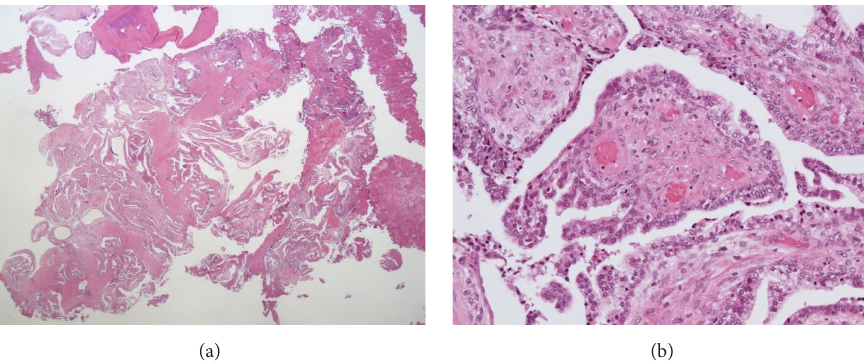
Figure 3: Pathological findings of TUR ((a) × 40, (b) × 400). There was benign hyperplasia not only in the stromal tissue but also in the